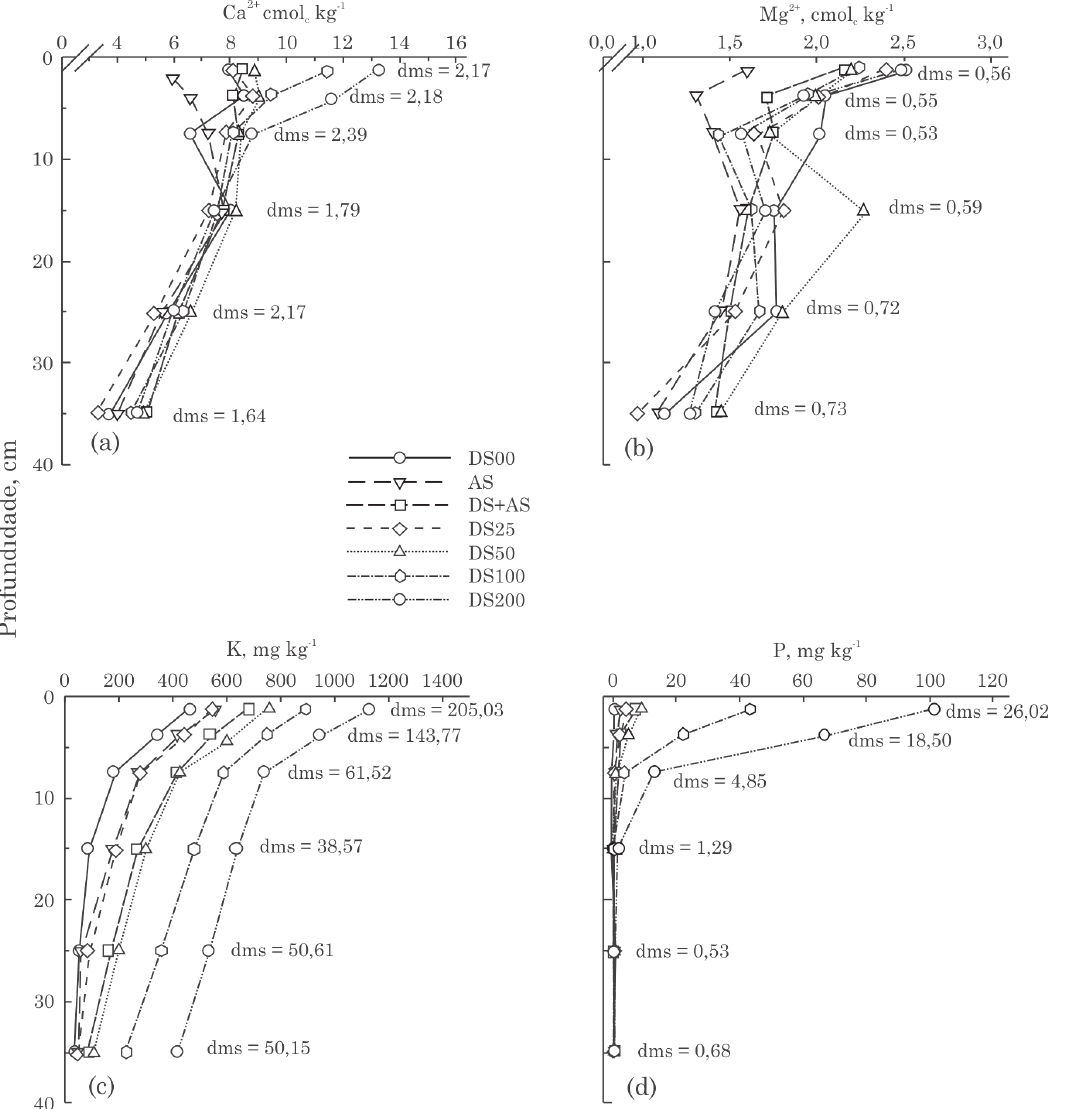
Figura 2. Teores de Ca (a) e Mg (b) trocáveis e de K (c) e P (d) extraíveis do solo nas camadas de 0-2,5, 2,5-5, 5-10, 10-20 e 30-40 cm de um Latossolo Vermelho distroférrico cultivado com a sucessão aveia-milho em sistema plantio direto e adubado anualmente com dejeto suíno nas doses de 0 (DS00), 25 (DS25), 50 (DS50), 100 (DS100) e 200 (DS200) m 3 ha -1 , adubo solúvel (AS) e dejeto suíno complementado com adubo solúvel (AS + DS). Aplicação inicial em outubro de 2001 e amostragem do solo em julho de 2010. O dms indica a diferença mínima significativa entre médias de tratamentos nas camadas pelo teste de Tukey a 5